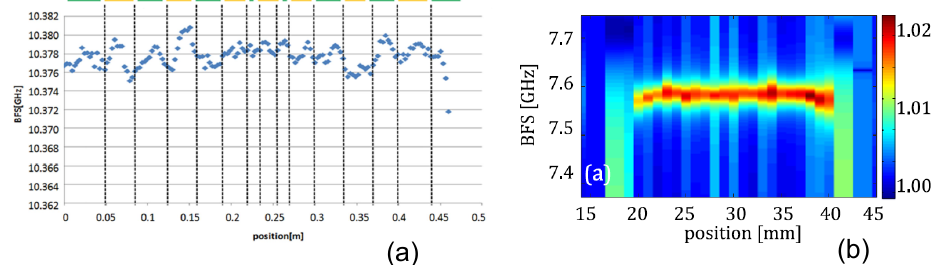
Figure 11. Mapping of ( a ) a silica planar waveguide with a spatial resolution of 5.9mm using frequency-modulated BOCDA [46] (reprinted with permission from [46], SPIE) and ( b ) a chalcogenide photonic waveguide with a spatial resolution of 2.5mm using ASE-based BOCDA measurement [48] (reprinted from [48] under a Creative Commons Attribution 4.0 International Public License).